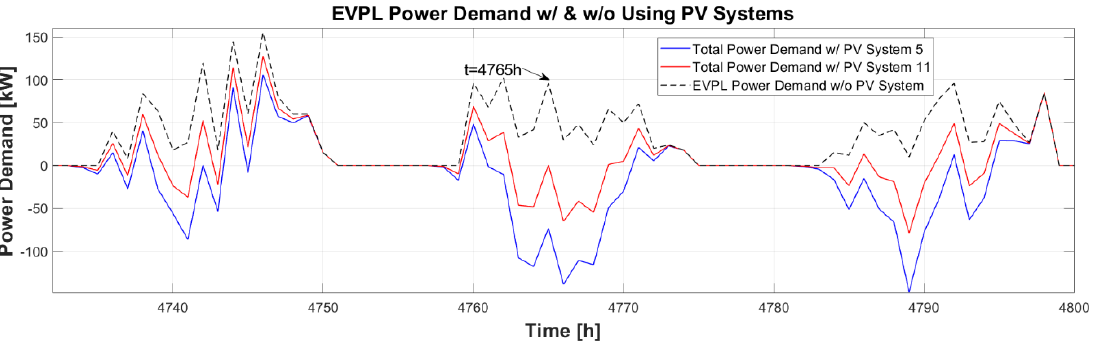
Figure 11. Schematic diagram of the IEEE 123 Nodes Test Feeder.